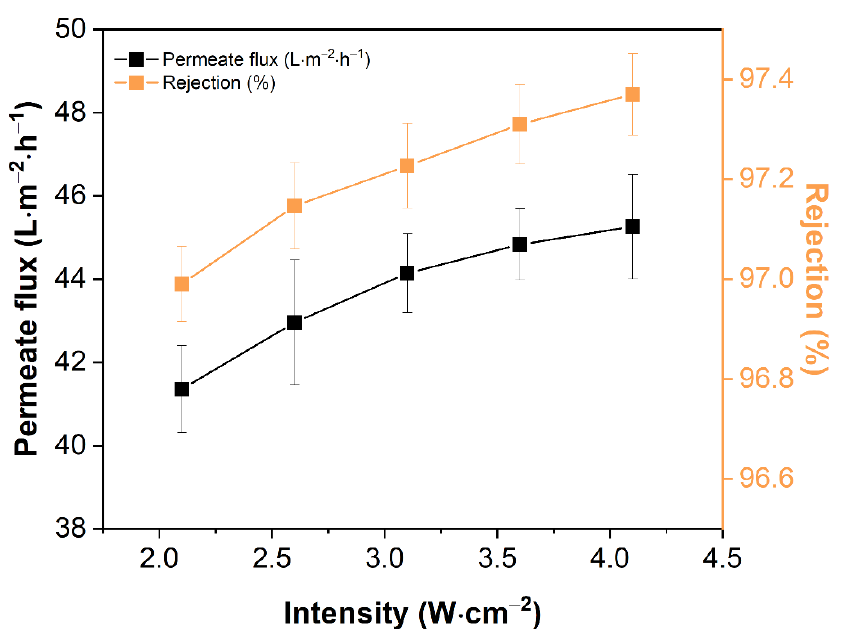
Figure 8. Permeate flux (black dot line) and rejection (orange dot line) of RO membrane after 10 min cleaning under different intensities from 2.1 to 4.1 W·cm −2 . Before ultrasonic cleaning, the membrane had been running for 10 h under optimal operating conditions. Membrane operating conditions: feed solution, Na 2 SO 4 ; feed concentration, 2500 mg·L −1 ; feed flow rate, 35 L·h −1 ; operating pressure, 0.5 MPa; temperature, 18 °C; pH, 7. Ultrasound generation conditions: frequency, 25 kHz.